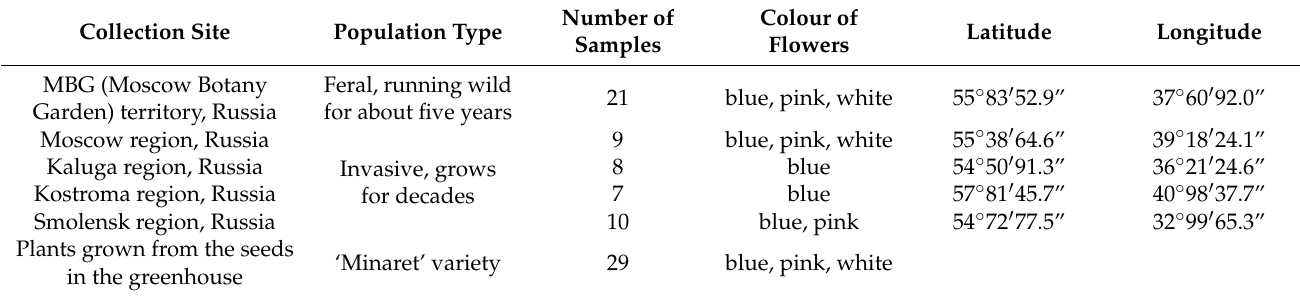
Table 1. Phenotypes, collection sites and population types of the L. polyphyllus